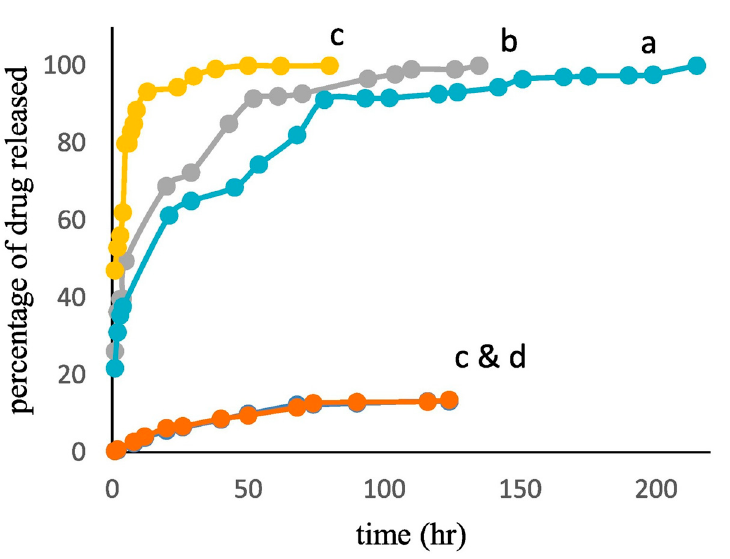
Figure 9. The in vitro release profile of MMIP, MIP NPs and MNIP (a, b, and c, at pH 5), MMIP and MIP NPs (c and d at pH 7.4). Reproduced with permission from Hassanpour et al. [127]. In addition, the MMIPs achieved ~50-fold higher cytotoxicity to MCF-7 cancer cells relative to free azidothymidine while having no effect on MCF-10 (healthy) cells. Alt-